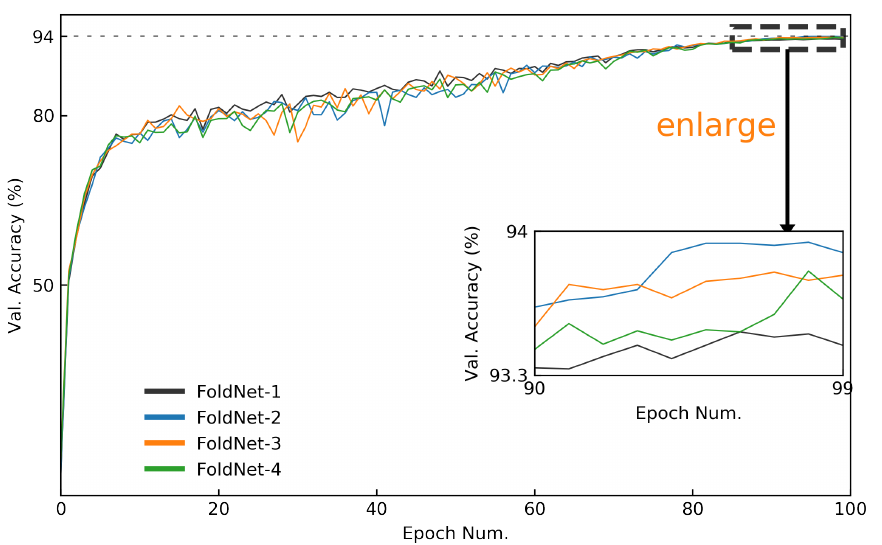
Figure 6. Validation accuracy curves of FoldNet for CIFAR-10 dataset when hidden dimension h = 64 and network depth n = 48. The validation accuracy curves of the last 10 epochs are enlarged to compare the accuracies of FoldNet- d more clearly.